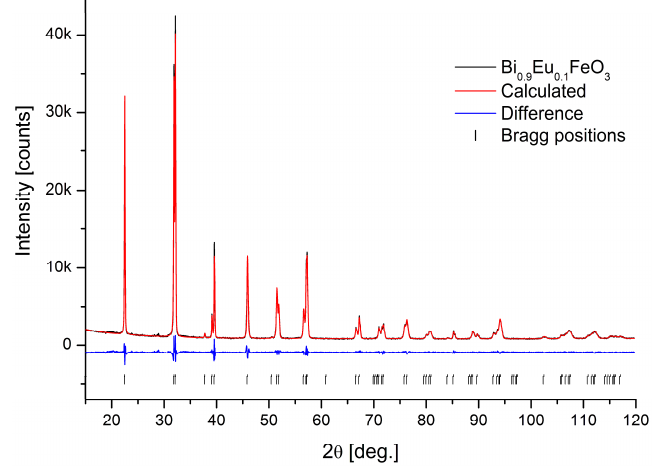
Figure 2. Polyhedral presentation of the BiFeO 3 crystal structure.